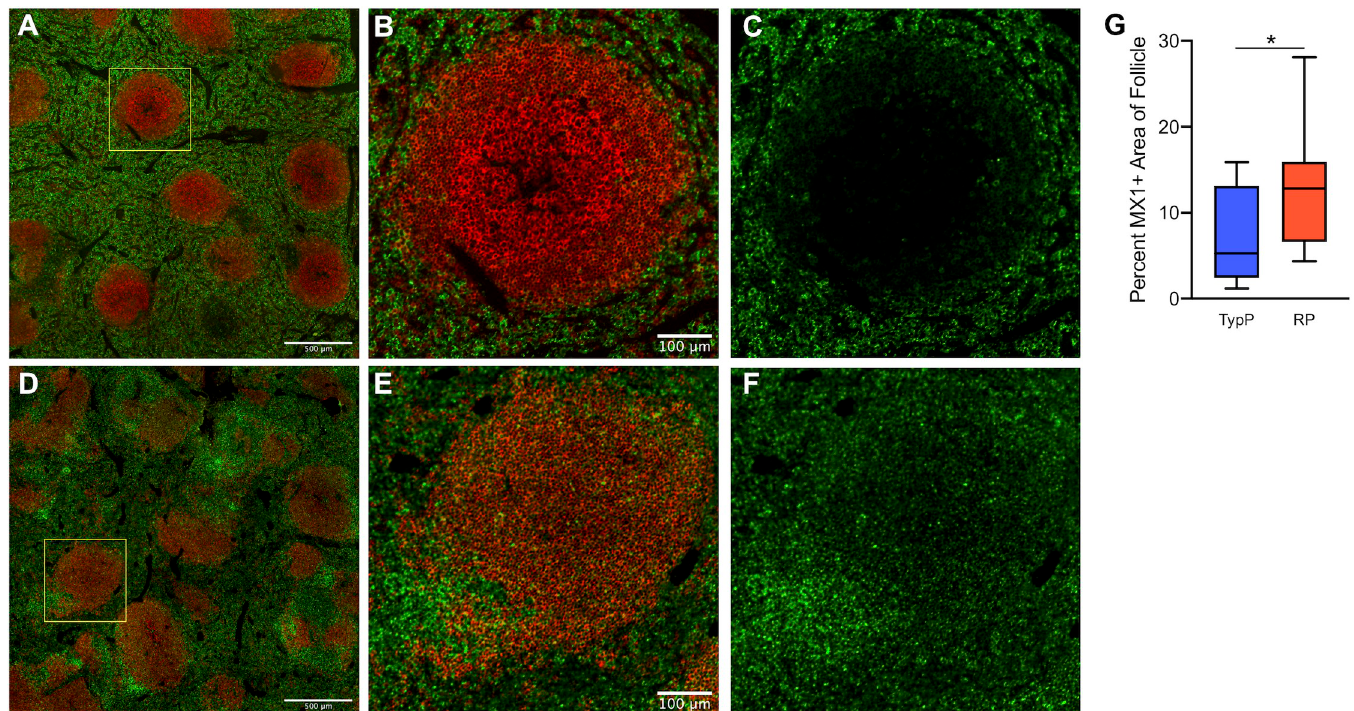
Fig 8. Increased type 1 IFN associated protein expression is observed in B cell follicles of RP infants. Levels of MX1 protein were measured in areas within B cell follicles of spleen. Paraffin embedded spleens from RP and TypP infants were sectioned and immuno-stained for B cells (CD20, red) and MX1 (green) to identify splenic B cell follicles and IFN-induced protein expression. Representative images are shown for TypP infants ( A-C ) and RP infants ( D-F ). Whole sections were scanned and stitched and MX1 was quantified within 10 randomly selected splenic B cell follicles ( G ) for TypP ( blue bar ) and RP ( red bar ) infants. Statistical tests used to compare infant groups were carried out as described in the methods � = p <